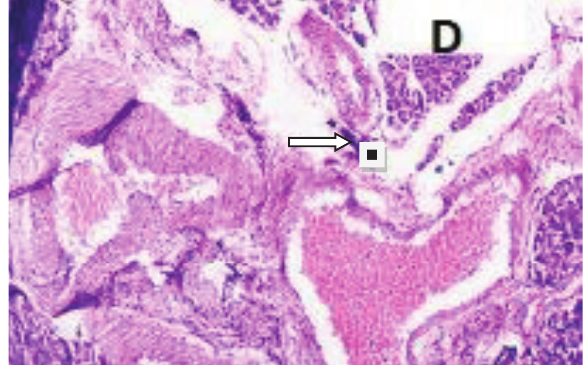
Fig-8: Group D (HFD+STZ+Canagliflozin) Some restoration in size and number of islets, ballooning and karyolysis still present after treatment with cana alone (40x; H&E)